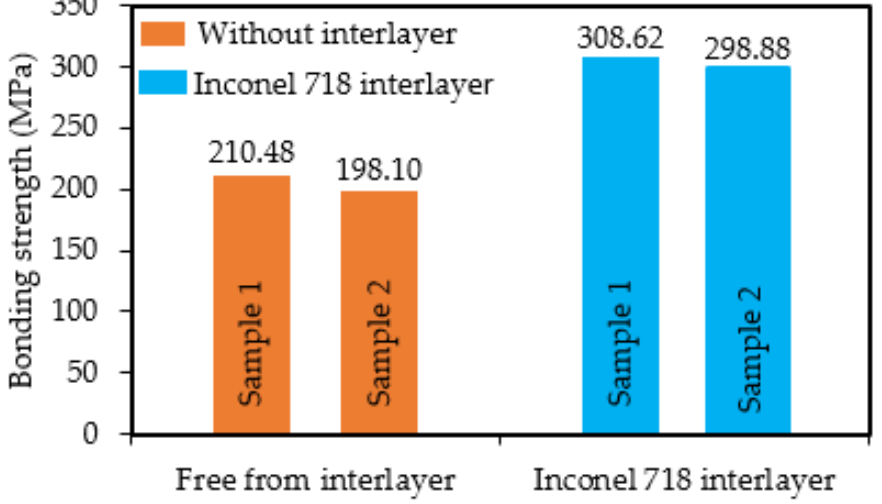
Figure 10. Bonding strength of samples with the Inconel 718 interlayer and without interlayer. Defects, including micropores and microcracks, in the deposited samples can pri- marily be attributed to the degradation in tensile strength (bonding strength). For the